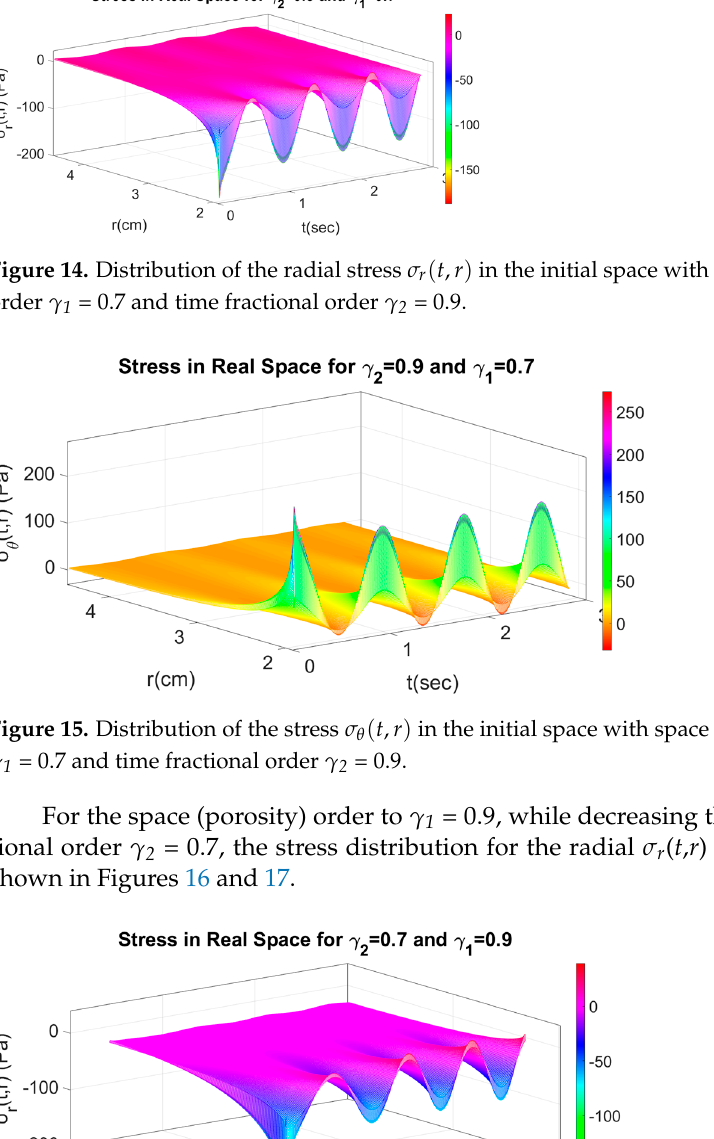
Figure 13. Distribution of the stress 𝜎 (cid:3087) (𝑡,𝑟) in the initial space with space (porosity) fractional order γ 1 = 0.9 and time fractional order γ 2 = 0.9.